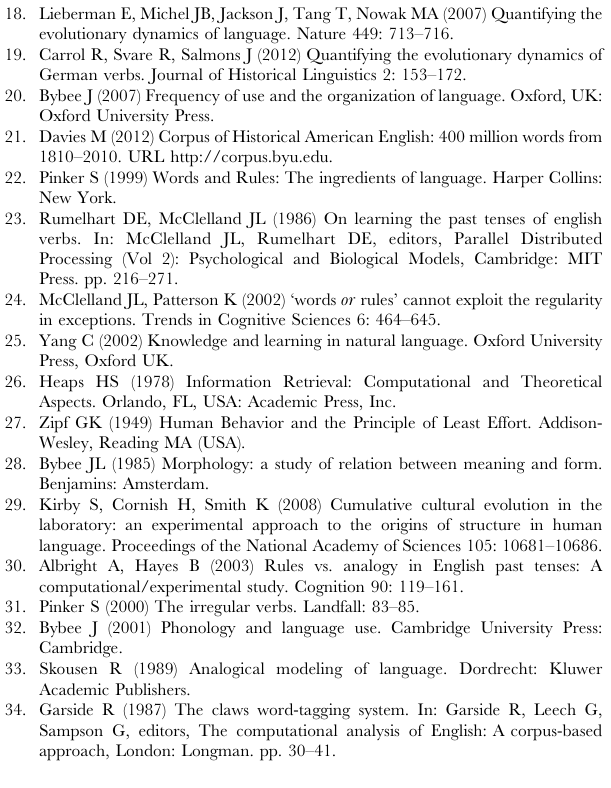
Figure S1 : Heap and Zipf distributions of verbs in CoHA prior to confining. Figure S2 : Verb tokens per decade prior to and after confining. Figure S3 : Frequency histogram of root types by